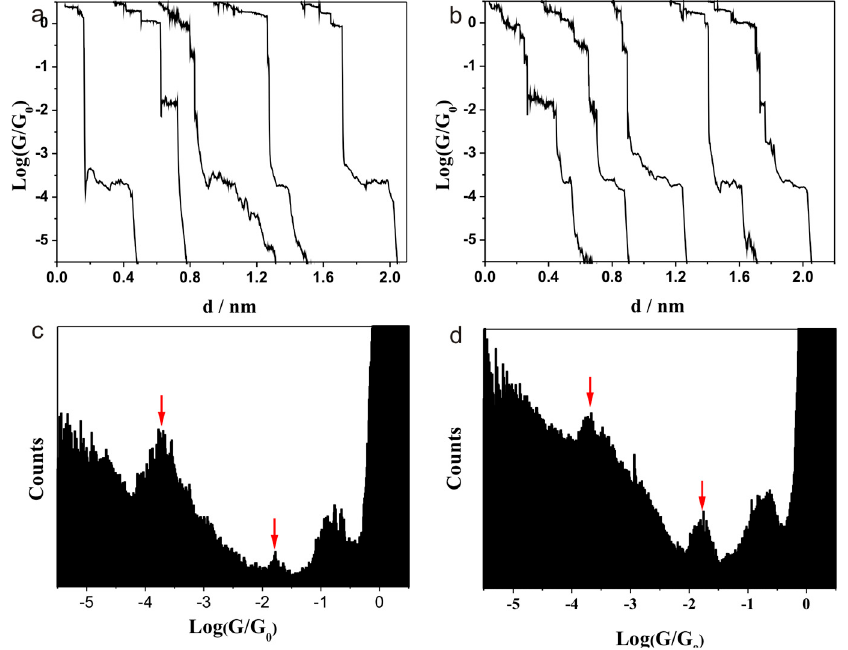
Figure 3. Typical conductance curves for ( a ) aspartic acid and ( b ) glutamic acid. Conductance histograms of ( c ) aspartic acid (from 1380 curves) and ( d ) glutamic acid (from 3000 curves) using Au as electrode.